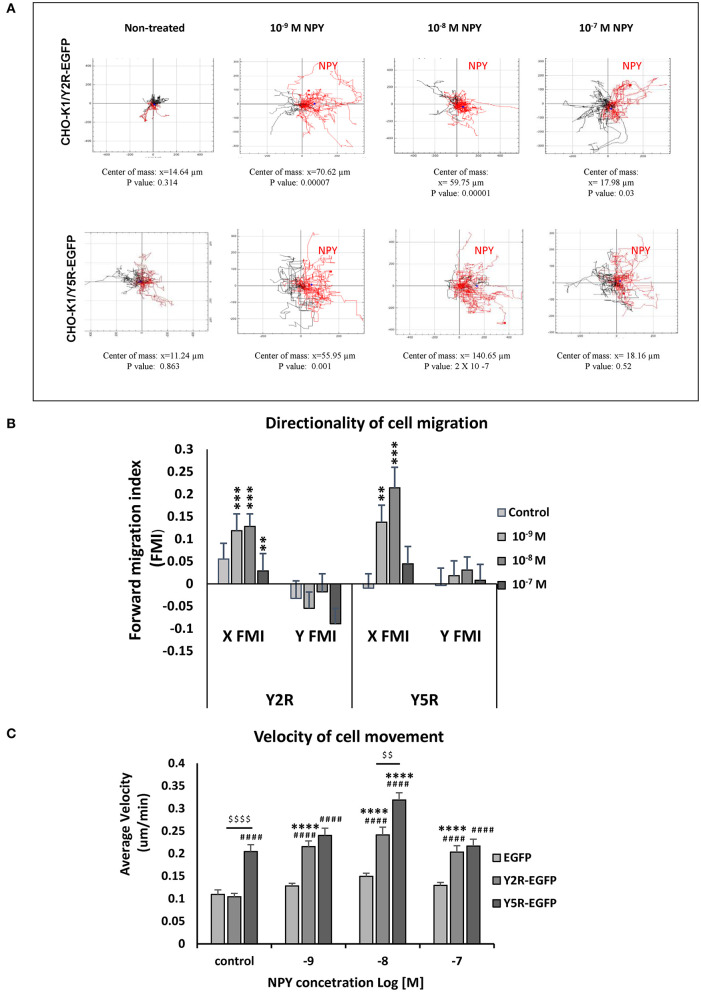
Y2R and Y5R mediate the chemotactic effect of NPY. (A) Trajectory plots showing tracks of individual CHO-K1/Y2R-EGFP or CHO-K1/Y5R-EGFP cells migrating in the chemotaxis chambers with various concentrations of NPY (10−9-10−7 M). Red tracks represent cells with net movement toward neuropeptide Y (NPY); black tracks represent cells migrating away from NPY. The center of mass represents the average of all single cell endpoints. P-values by the Rayleigh test for the uniformity of a circular distribution of points. (B) Quantification of the forward migration index (FMI) in a direction parallel (X) or perpendicular to the NPY gradient (Y). **p < 0.01; ***p < 0.001; X FMI vs. Y FMI for the given NPY concentration by t-test. (C) Average cell velocity for CHO-K1 transfectants under control conditions or upon treatment with NPY (10−9-10−7 M). ####p < 0.0001 vs. CHO-K1/EGFP control; ****p < 0.0001 vs. untreated control within the same cell line; $$$$p < 0.0001 as shown, by one-way ANOVA followed by Tukey's test; mean ± SEM; n = 39–41 per condition.